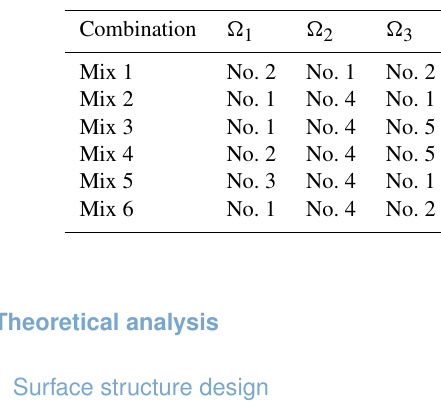
Table 4. Combination matching